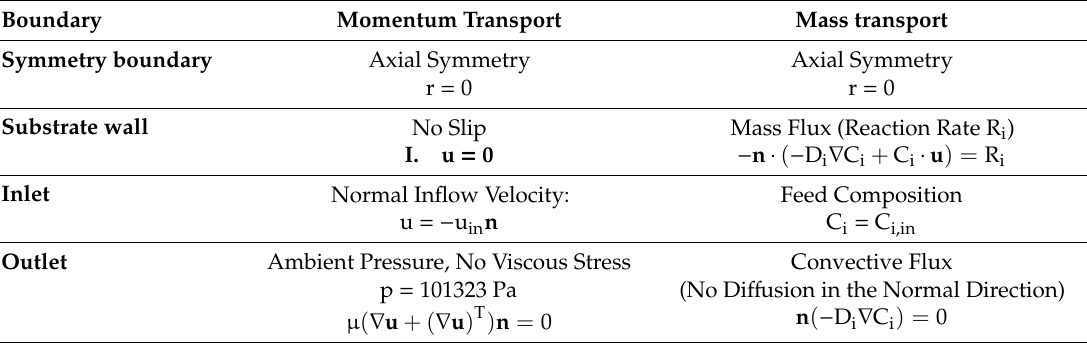
Table 1. Boundary conditions for the momentum and mass transport in the isothermal 2-D computational fluid dynamic (CFD) model for the determination of the gas–solid mass transfer coefficients. Boundary Momentum